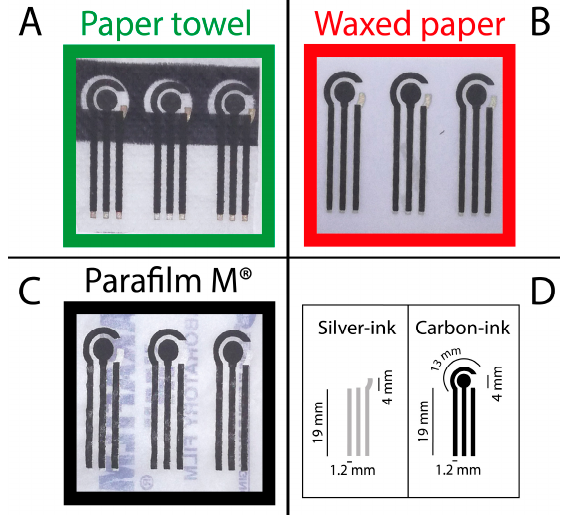
Figure 1. Photographs of electrodes screen-printed on ( A ) paper towel; ( B ) waxed paper; and ( C ) Parafilm ® ; ( D ) Dimensions of the conductive tracks that have been screen-printed.